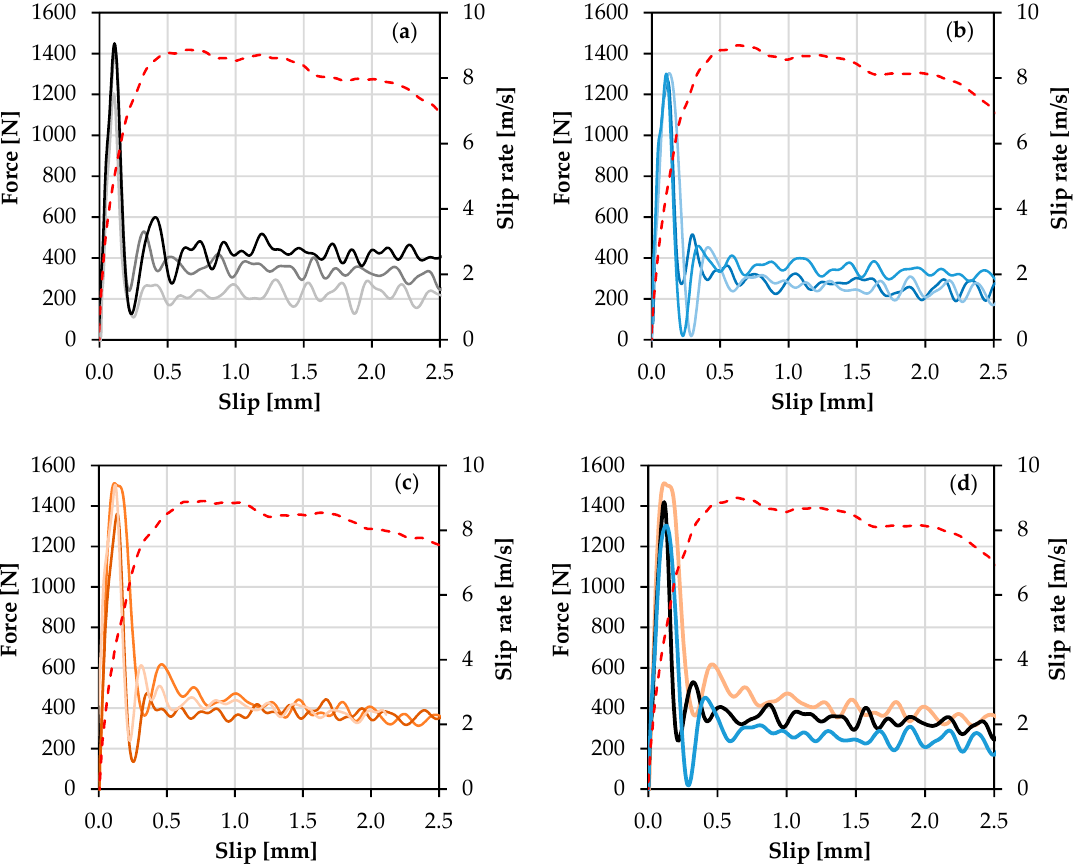
Figure 13. Dynamic force-slip relationships of single carbon yarns pulled out from: ( a ) plain matrix; ( b ) PE-SHCC; ( c ) PBO-SHCC; and ( d ) representative force-slip relationships for different composites up to a slip extent of 2.5 mm (the global strain rate curves are represented by dashed lines). Table 9. Peak debonding force obtained from high-speed pullout tests with three different matrices (average values; standard deviations are given in parentheses).